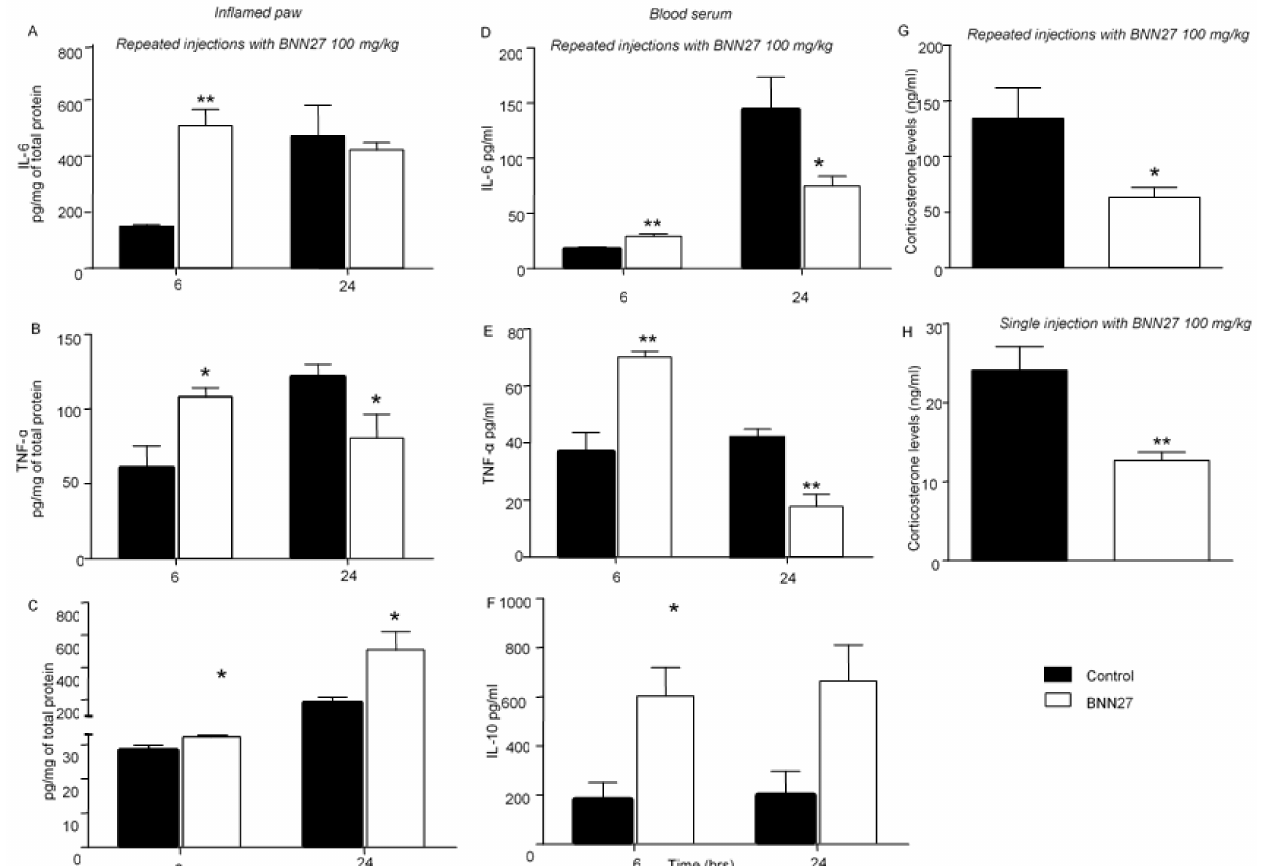
Figure 4. BNN27 affected cytokine production in the inflamed paw and blood serum. Repeated injections of BNN27 100 mg/kg increased the IL-6 and TNF- α levels in the inflamed paw ( A , B , D , E ) at 6 h while it decreased TNF- α at 24 h both in the inflamed paw and blood serum ( B , E ). IL-10 remained elevated at all time points examined in the same tissues as above ( C , F ). Repeated or single administration of BNN27 100 mg/kg decreased serum levels of corticosterone ( G , H ). ( A ) At 6 h: Control n = 3 mice, BNN27-treated group n = 3 mice; at 24 h: Control n = 10 mice, BNN27-treated group n = 10 mice; ( B ) At 6 h: Control n = 4 mice, BNN27-treated group n = 4 mice; at 24 h: Control n = 4 mice, BNN27-treated group n = 5 mice; ( C ) At 6 h: Control n = 4 mice, BNN27-treated group n = 4 mice; at 24 h: Control n = 6 mice, BNN27-treated group n = 5 mice; ( D ) At 6 h: Control n = 4 mice, BNN27-treated group n = 4 mice; at 24 h: Control n = 3 mice, BNN27-treated group n = 4 mice; ( E ) At 6 h: Control n = 3 mice, BNN27-treated group n = 4 mice; at 24 h: Control n = 3 mice, BNN27-treated group n = 3 mice; ( F ) At 6 h: Control n = 4 mice, BNN27-treated group n = 4 mice; at 24 h: Control n = 3 mice, BNN27-treated group n = 4 mice; ( G ) Control n = 9 mice, BNN27-treated group n = 8 mice; ( H ) Control n = 3 mice, BNN27-treated group n = 4 mice. In all panels * p < 0.05, ** p < 0.01. Statistical analysis was performed using unpaired t -tests. All data are expressed as the mean ±